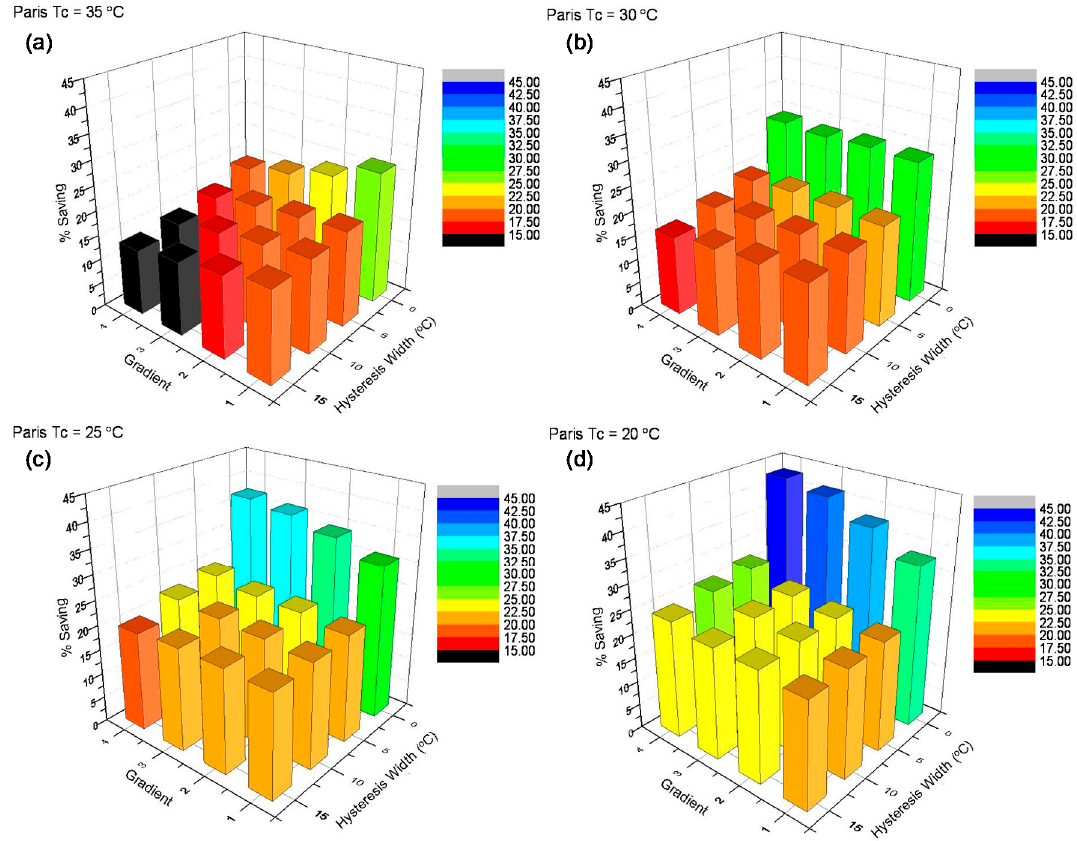
Figure 5. Energy demand reduction improvements for thermochromic glazing in Paris with a transition temperature of ( a ) 35 °C, ( b ) 30 °C, ( c ) 25 °C and ( d ) 20 °C.